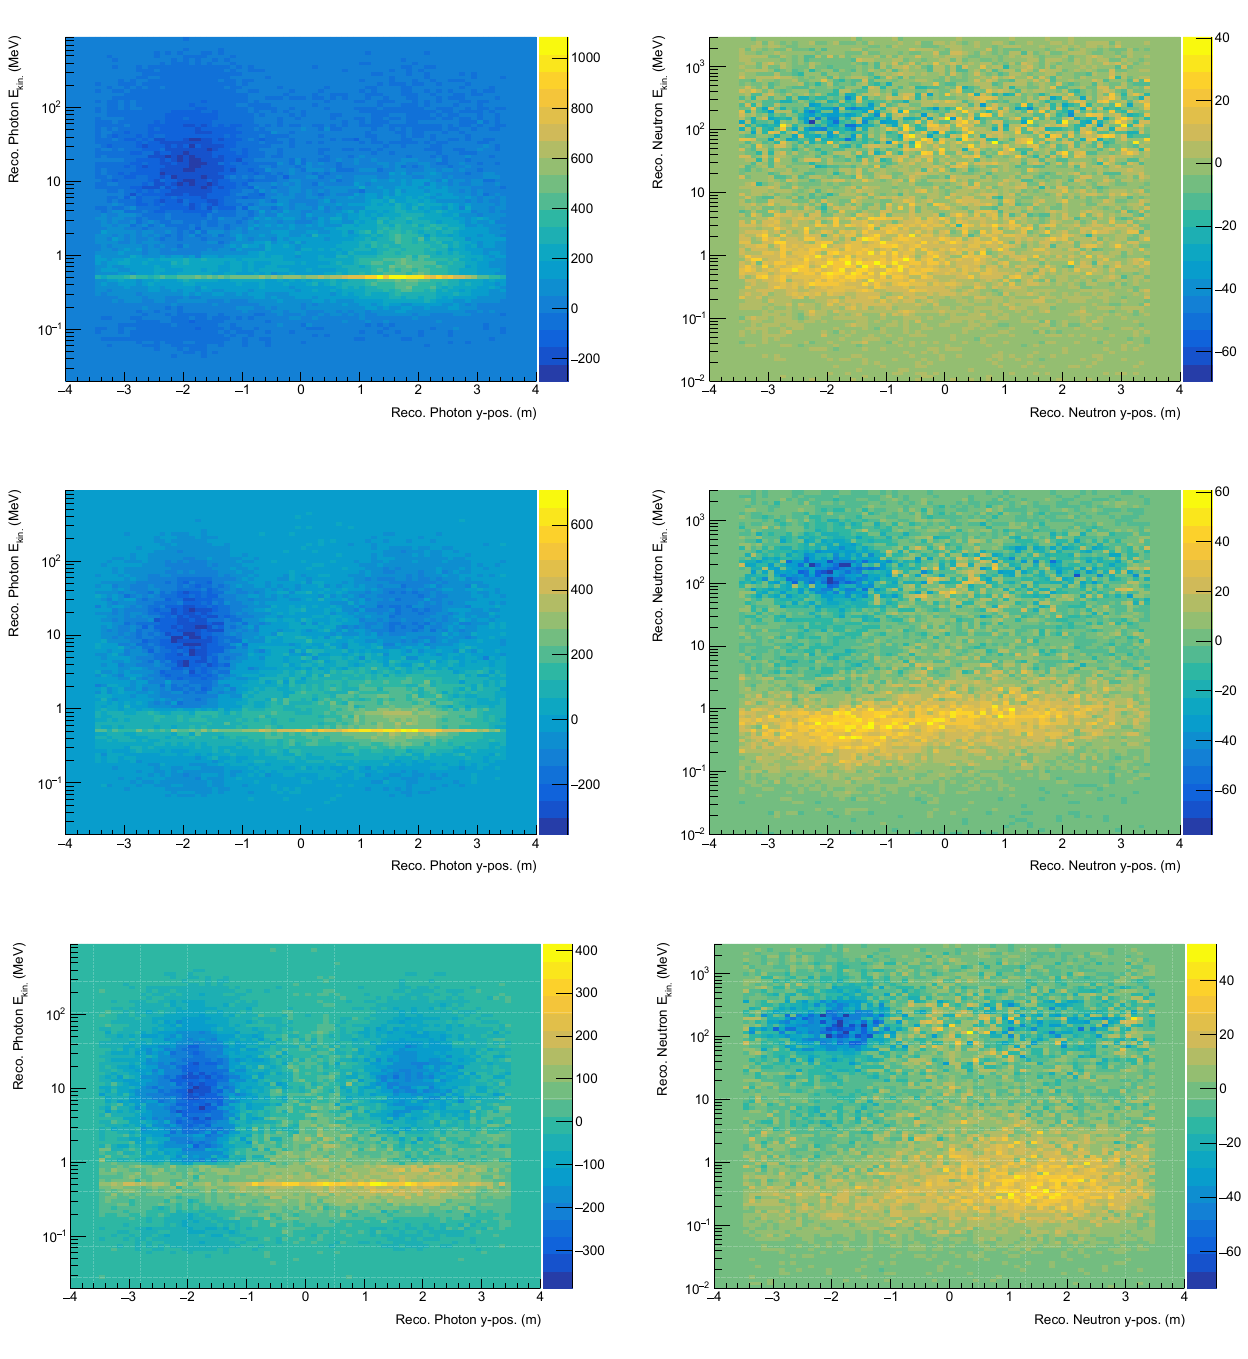
Figure 4. The distribution of the kinetic energy E kin . as a function of the y -position of the reconstructed photons ( left column ) and neutrons ( right column ) in the lower detector plane. The materials analyzed are Cesium ( upper row ), Tin ( middle row ) and Palladium ( bottom row ). The hits from the empty container are